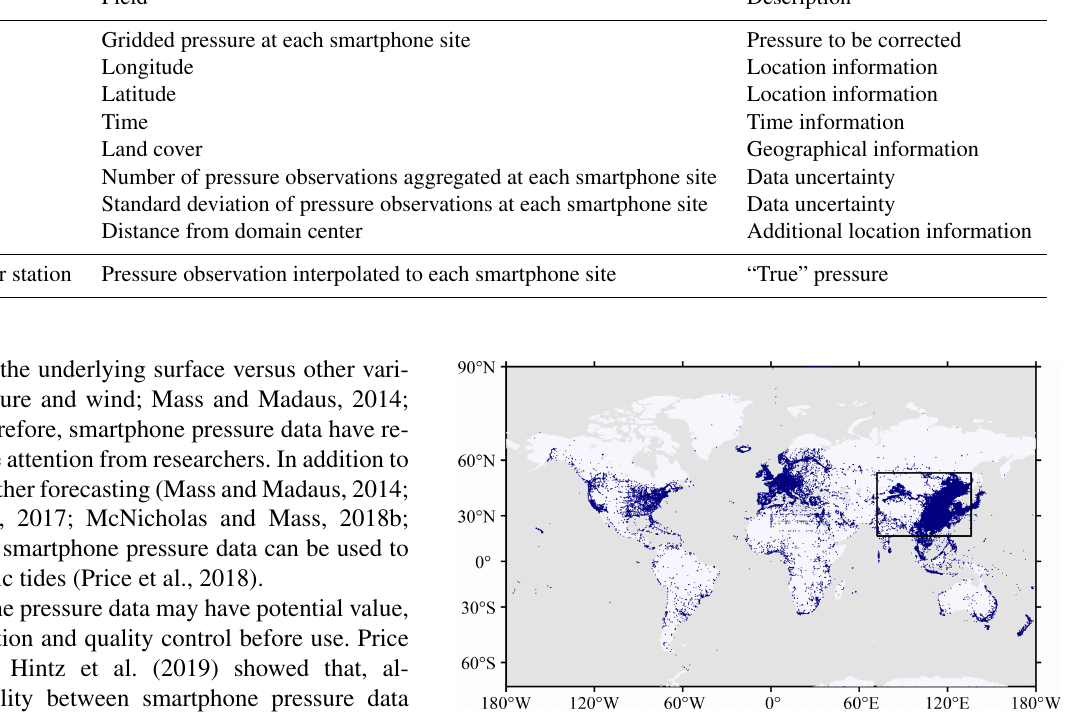
Figure 2. Locations of global pressure observations in 2016 from the Moji Weather